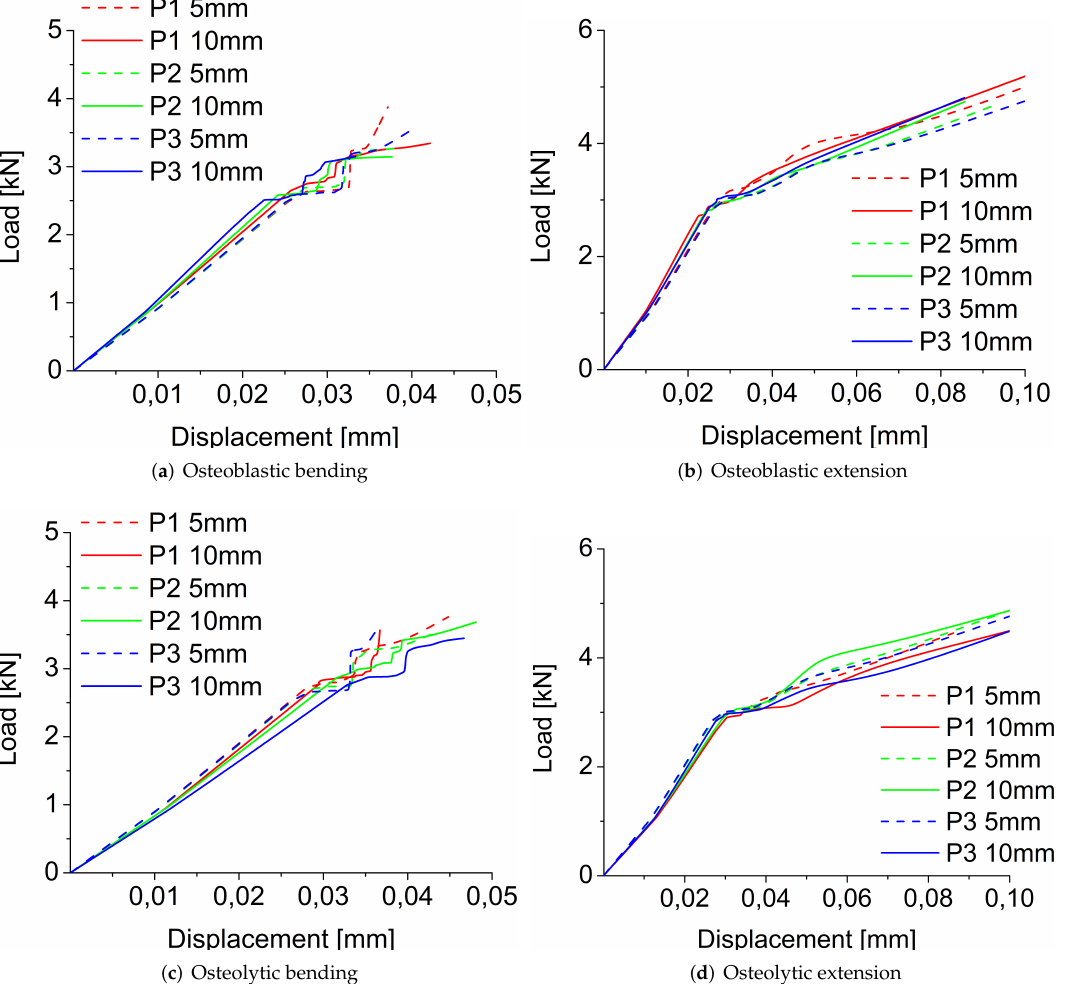
Figure 7. Load-displacement curves obtained for osteoblastic, ( a , b ); and osteolytic, ( c , d ); metastases in bending, ( a , c ); and extension, ( b , d ); loading modes using the stress-based failure criterion varying the radius and position of